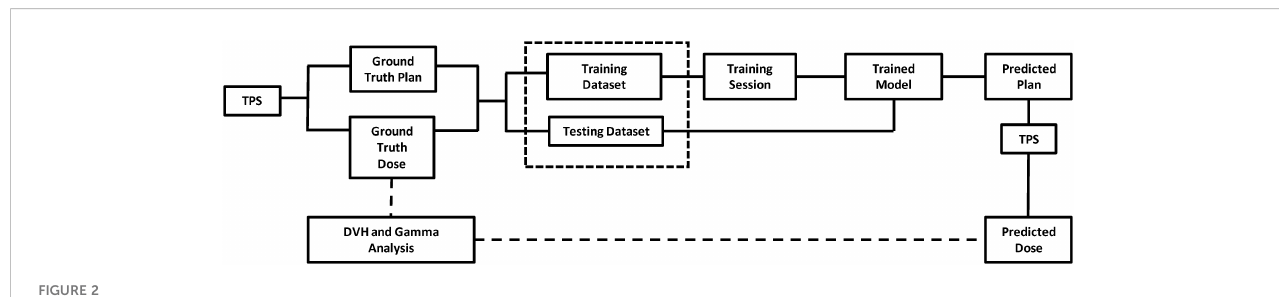
FIGURE 2 High-level work fl ow of study